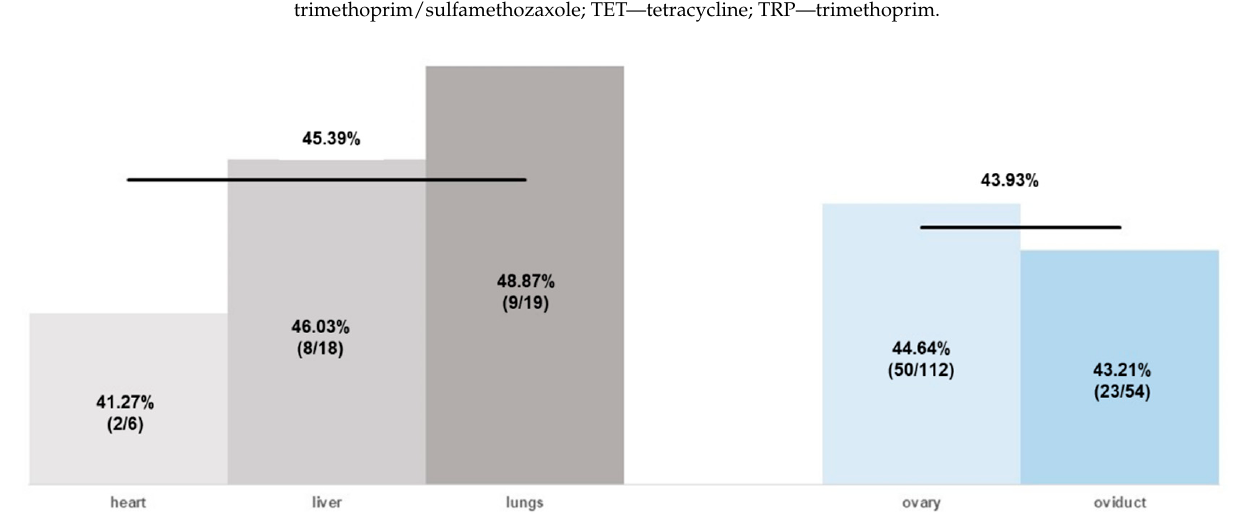
Figure 3. Number of antimicrobial substances to which E. coli isolates were resistant, shown in rela- tion to the age of birds (S1 = sampling point 1, age ~17 weeks; S2 = sampling point 2, age ~38 weeks; S3 = sampling point 3, age ~74 weeks). The mean number of antimicrobials to which E. coli isolates were resistant was 8.38 for S1, 10.04 for S2, and 9.87 for S3.